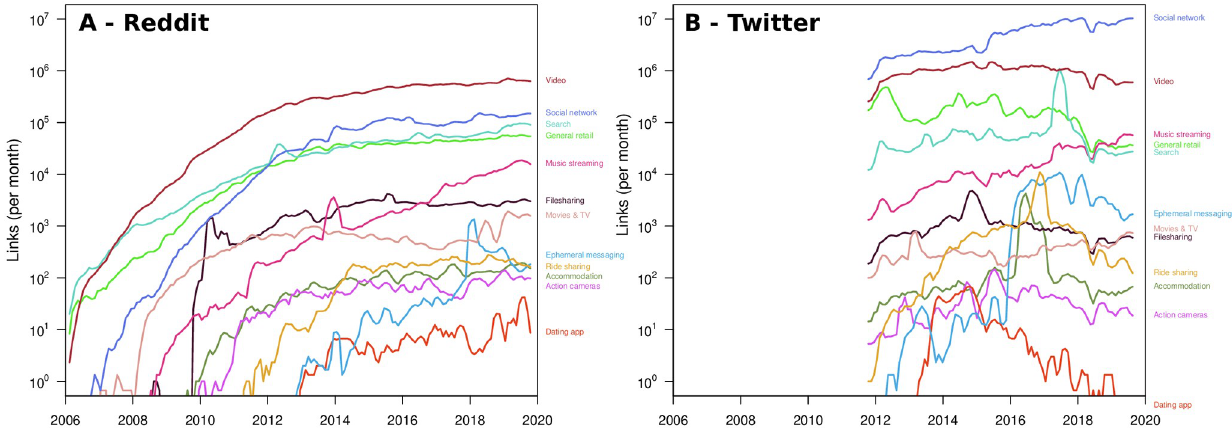
Fig 5. Growth of functional diversity on the Reddit (A) and Twitter (B) platforms. The lines shows the number of links to different functions as indicated by the leading organisations and their top-three rivals (see Sec. Categorising new functions and innovation in the online economy for details).